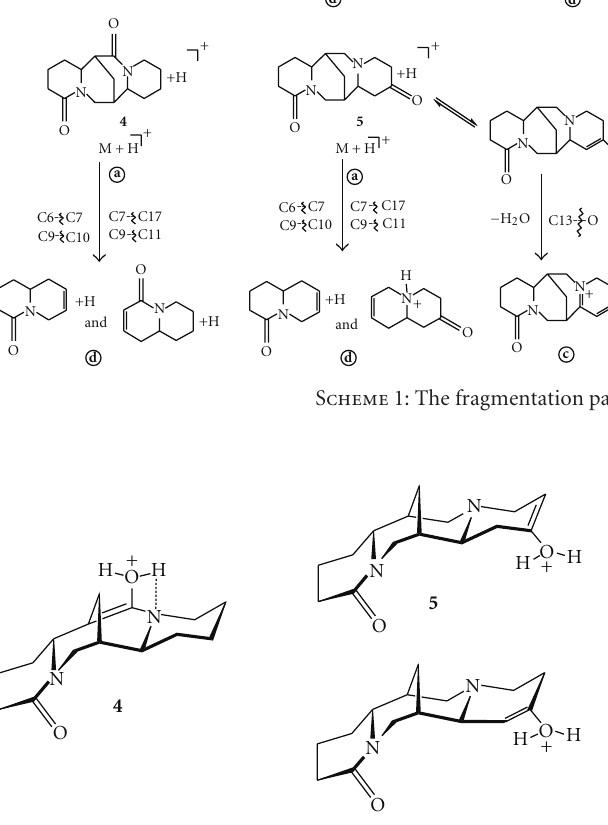
Figure 2: Structures of tautomeric enol forms of 4 and 5 .